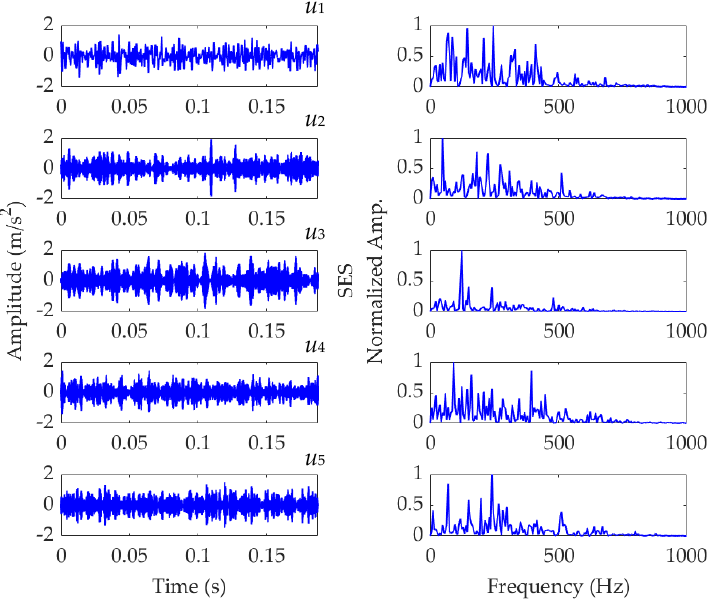
Figure 5. Results of the simulated vibration signal x ( t ) obtained using SVMD with α opt = 950.